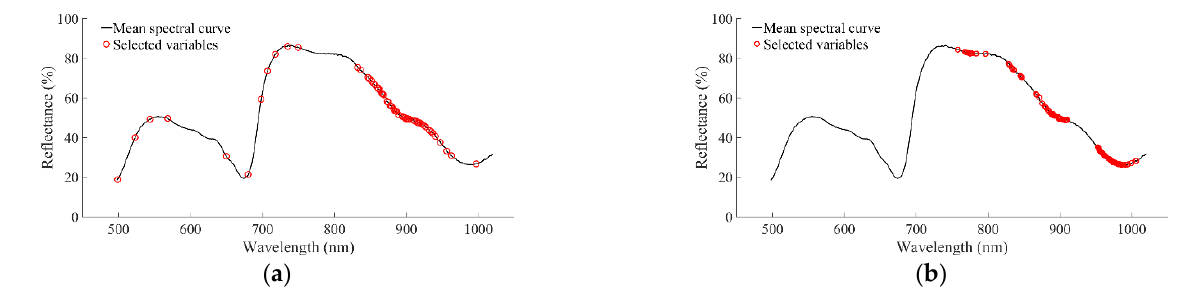
Figure 4. Distribution of characteristic wavelengths. ( a ) SPA; ( b ) MCUVE.